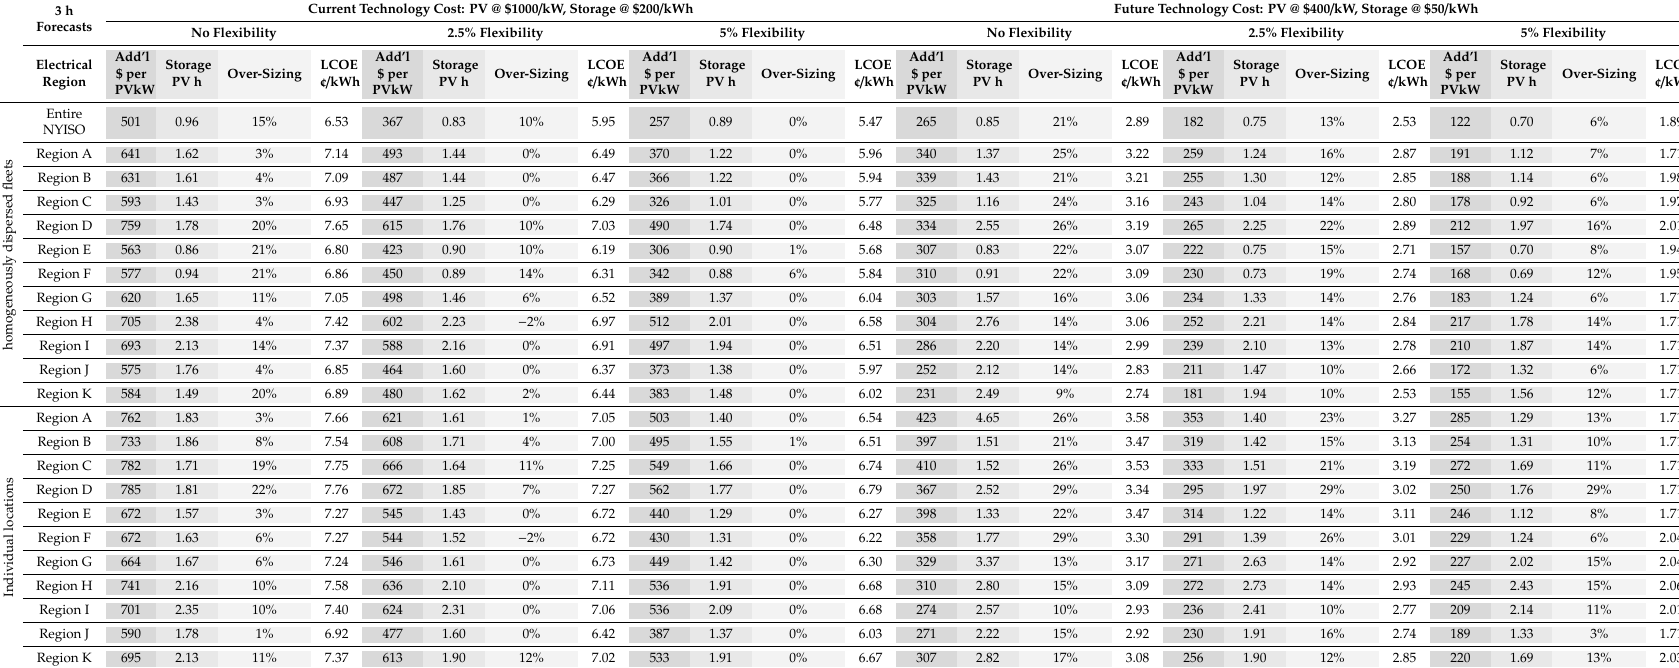
Table A6. Three-hours-ahead firm forecast results applying